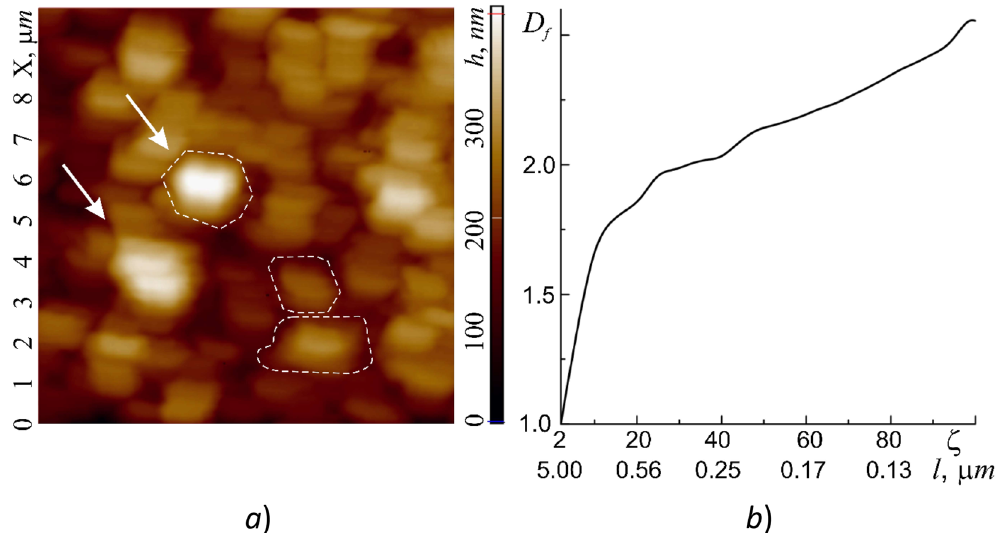
Figure 7. Image of a 10 × 10 μm region of the cell wall surface obtained in the hybrid AFM mode at a resolution of 100 × 100 scanning points (some elements of the cellular structure are circled with a dotted line): relief h = h(x, y) ( a ) and dependence of fractal dimension D f = D f ( ζ ) on the values of the scaling coefficient ζ ( b ). Under the values of ζ the corresponding for the investigated area values of the measuring scales l are